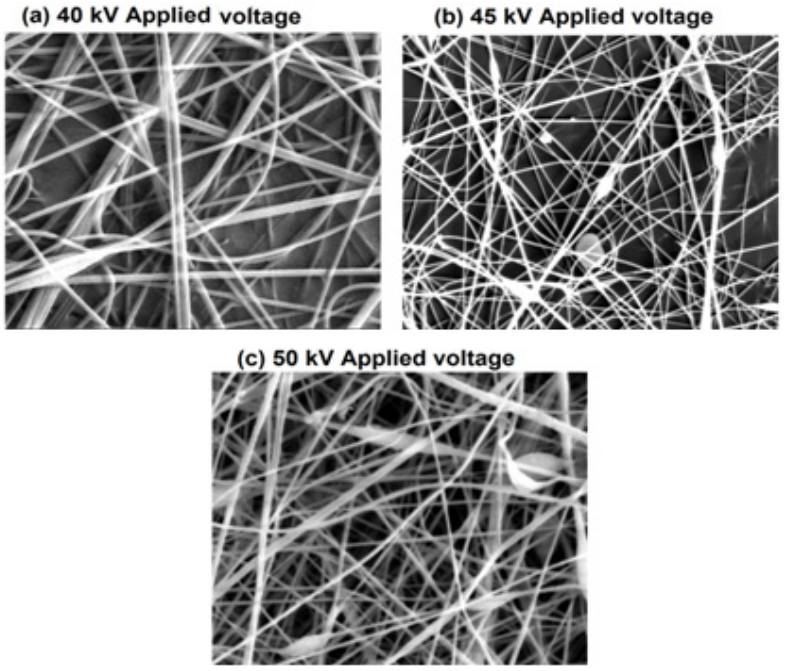
Figure 4. Histograms of nanofiber diameter at different concentration levels 18, 20, and 22 w / w % with constant applied voltage 45 kV and constant collecting distance 20 cm.